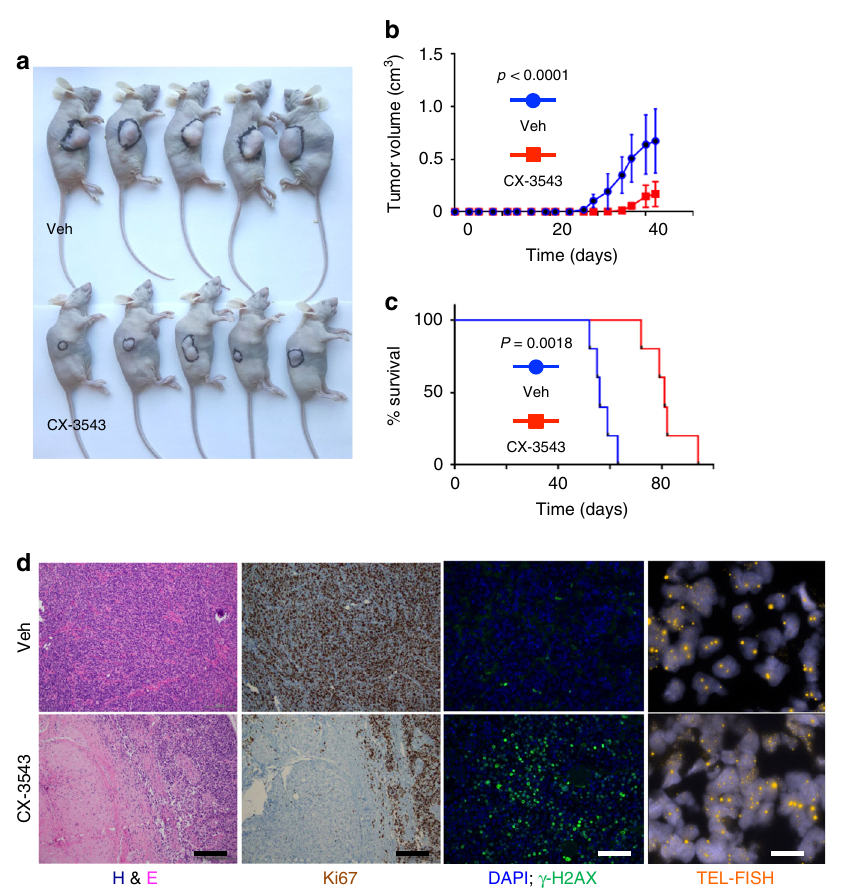
Fig. 7 G4 stabilization markedly slows the growth of ATRX-mutant glioma xenografts. a representative image of mice bearing JHH-273 xenografts following treatment with either vehicle (veh) or 12.5 mg/kg CX-3543 for 42 days. b Average xenograft volume over time in 10 mice randomized (5 and 5) into two groups, receiving either 12.5 mg/kg CX-3543 or vehicle control (veh). c Kaplan – Meier analysis of survival in a separate cohort of 10 mice randomized (5 and 5) into two groups, receiving either 12.5 mg/kg CX-3543 or vehicle control (Veh). d Representative H&E-stained, immunostained (Ki67 and γ -H2AX), and TEL-FISH stained sections of xenografts from vehicle (Veh) and CX-3543-treated mice. CX-3543-treated tumors showed decreased cellularity, decreased proliferative activity, and increased DNA damage. P values were determined by two-way ANOVA; scale bars represent 200 μ m in staining panels and 25 μ m in Tel-FISH